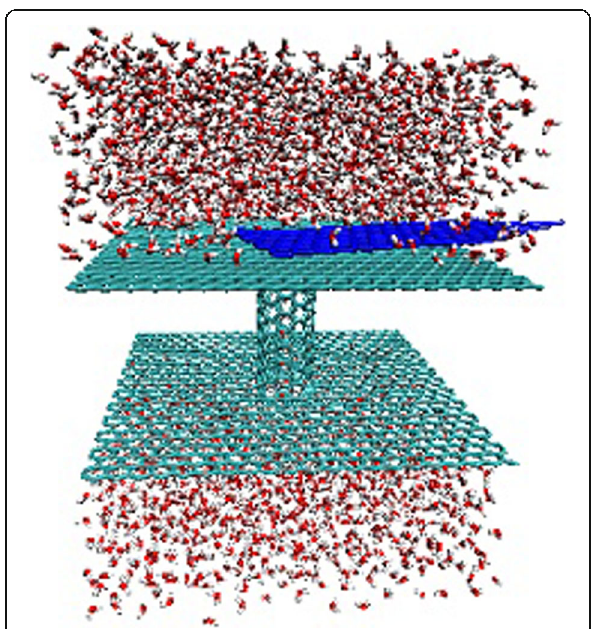
Fig. 1 Snapshot of the simulation system. A CNT with length of 2.56 nm and diameter of 0.81 nm, connecting two water reservoirs, separated by two graphite sheets (sage green, 5.1 × 5.1 nm 2 ). A small graphite sheet (blue) placed on the big one closely. The system was embedded in a periodic water box with 3328 water molecules, representing a nanometer water